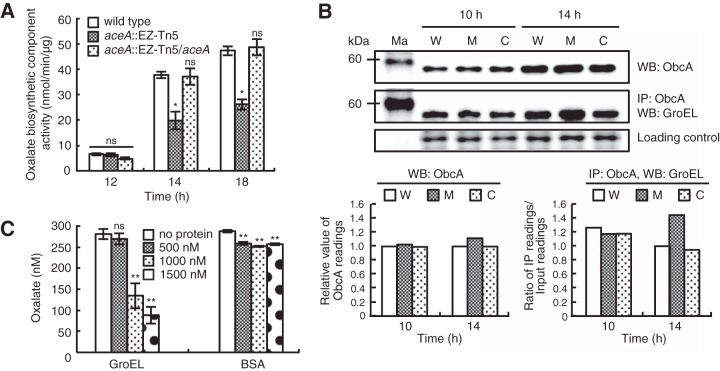
Physical interruption of the oxalate biosynthetic enzyme ObcA by metabolic stress-responsive GroEL in the aceA mutant of B. glumae. (A) The aceA mutant had approximately 50% of the oxalate biosynthetic activity of the wild-type strain. (B) Affinity pulldown experiments using anti-ObcA and anti-GroEL antibodies confirmed that GroEL interacts with ObcA, and the elevated levels of GroEL in the aceA mutant resulted in greater trapping of ObcA than was seen with the wild-type strain. Relative ObcA values were obtained by comparison with the wild-type values at two different time points as described previously (28). Ma, W, M, C, WB, and IP denote molecular markers, wild-type strain, aceA mutant, the complemented strain, Western blotting, and immunoprecipitation, respectively. The image of the SDS-PAGE gel stained with Coomassie brilliant blue R-250 (Bio-Rad) shows that samples were loaded equally in all lanes. (C) ObcA activity was decreased by approximately 4%, 52%, and 68% by addition of 500, 1,000, and 1,500 nM GroEL, respectively, compared to the control without GroEL in vitro. ObcA activity was not significantly affected by addition of 500, 1,000, and 1,500 nM BSA. Error bars represent the error ranges of experiments performed in triplicate. ns, no significant difference; *, P < 0.05; **, P < 0.001.